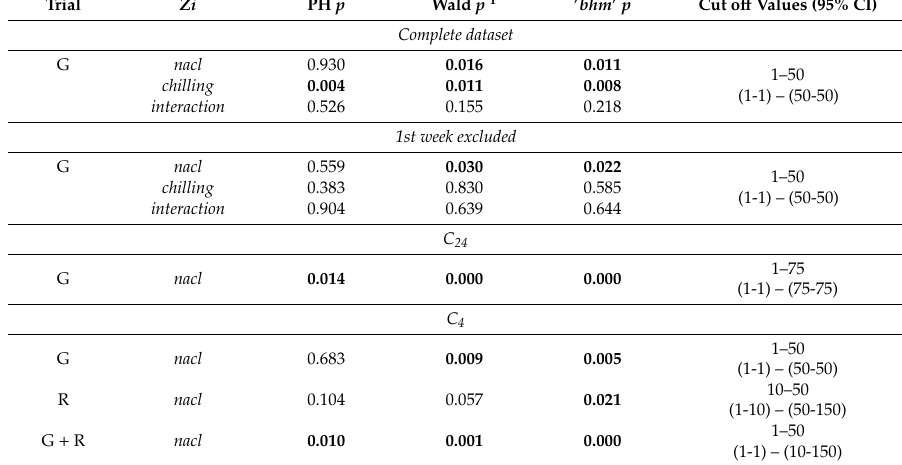
Table 2. Summary table for Cox proportional hazards (PH) regression model and cut o ff values for nacl biomarker threshold ( (cid:48) bhm (cid:48) ) in germination (G) and recovery (R) trials. Cox proportional hazard assumption (PH p ) rejected if p < 0.05 (in bold ). E ff ects ( Z i ) tested by Wald and (cid:48) bhm (cid:48) tests ( p < 0.05, in bold ). Cut o ff values for nacl biomarker threshold (in mM NaCl) by (cid:48) bhm (cid:48) analysis and their 95% CI (in brackets).